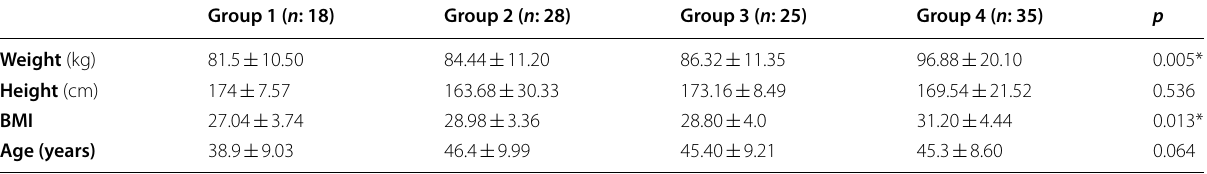
Group 1: AHI: < 5, group 2: AHI: 5–15, group 3: AHI: 15–30, group 4: AH >: 30. BMI body mass index. * p < 0.05 was accepted as statistically significant. mean deviation Table 2 Comparison of leukocyte measurements between the groups Measurements (BIN/mm 3